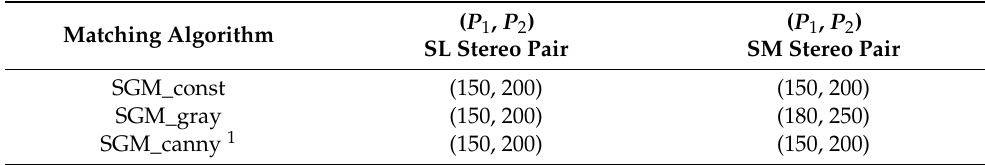
Table 3. Optimal parameter values of SGM penalty functions.